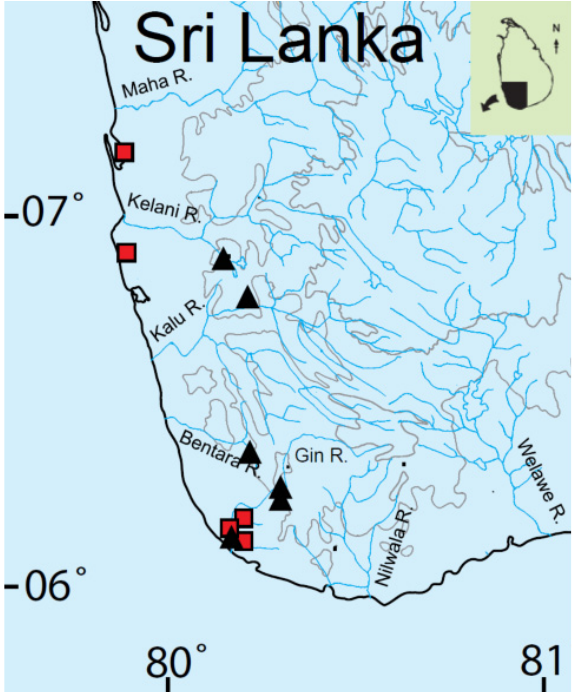
Figure 2. Records of Eleotris melanosoma (red squares) and Bunaka gyrinoides (black triangles) in Sri